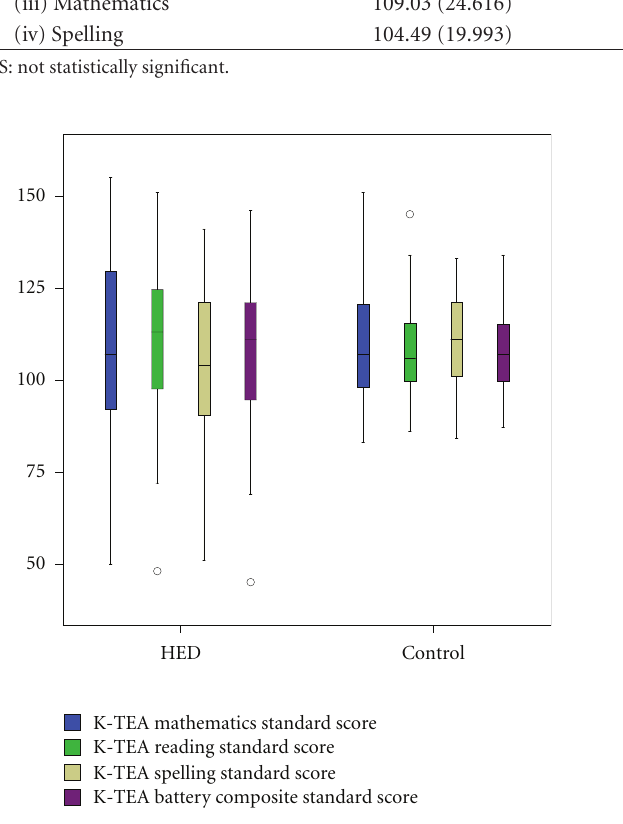
Figure 2: Comparison of K-TEA standard scores for children with HED and control